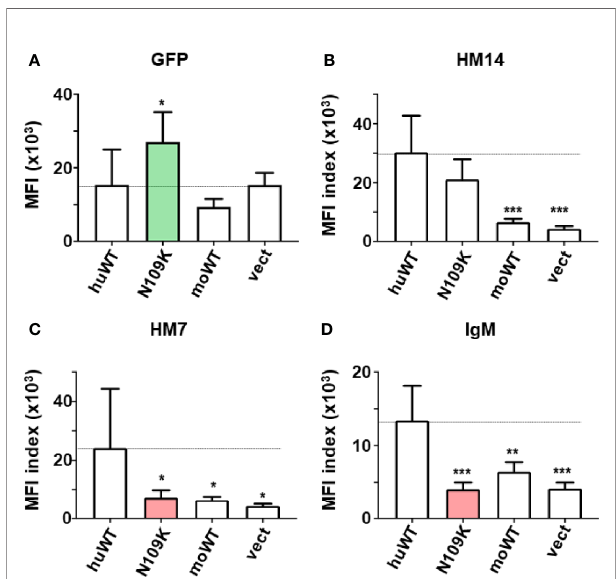
FIGURE 4 | Quantitative assessments of the GFP and FcµR expression and the IgM binding activity by the C-terminal FcµR mutant N109K. MFI indices of the expression of GFP (A) , the reactivity of HM14 (B) and HM7 (C) and the binding of IgM (D) by the human FcµR transductants of WT and the N109K mutant as well as in control transductants were plotted as mean ± 1 SD from seven independent experiments. Lines correspond with the MFI index of